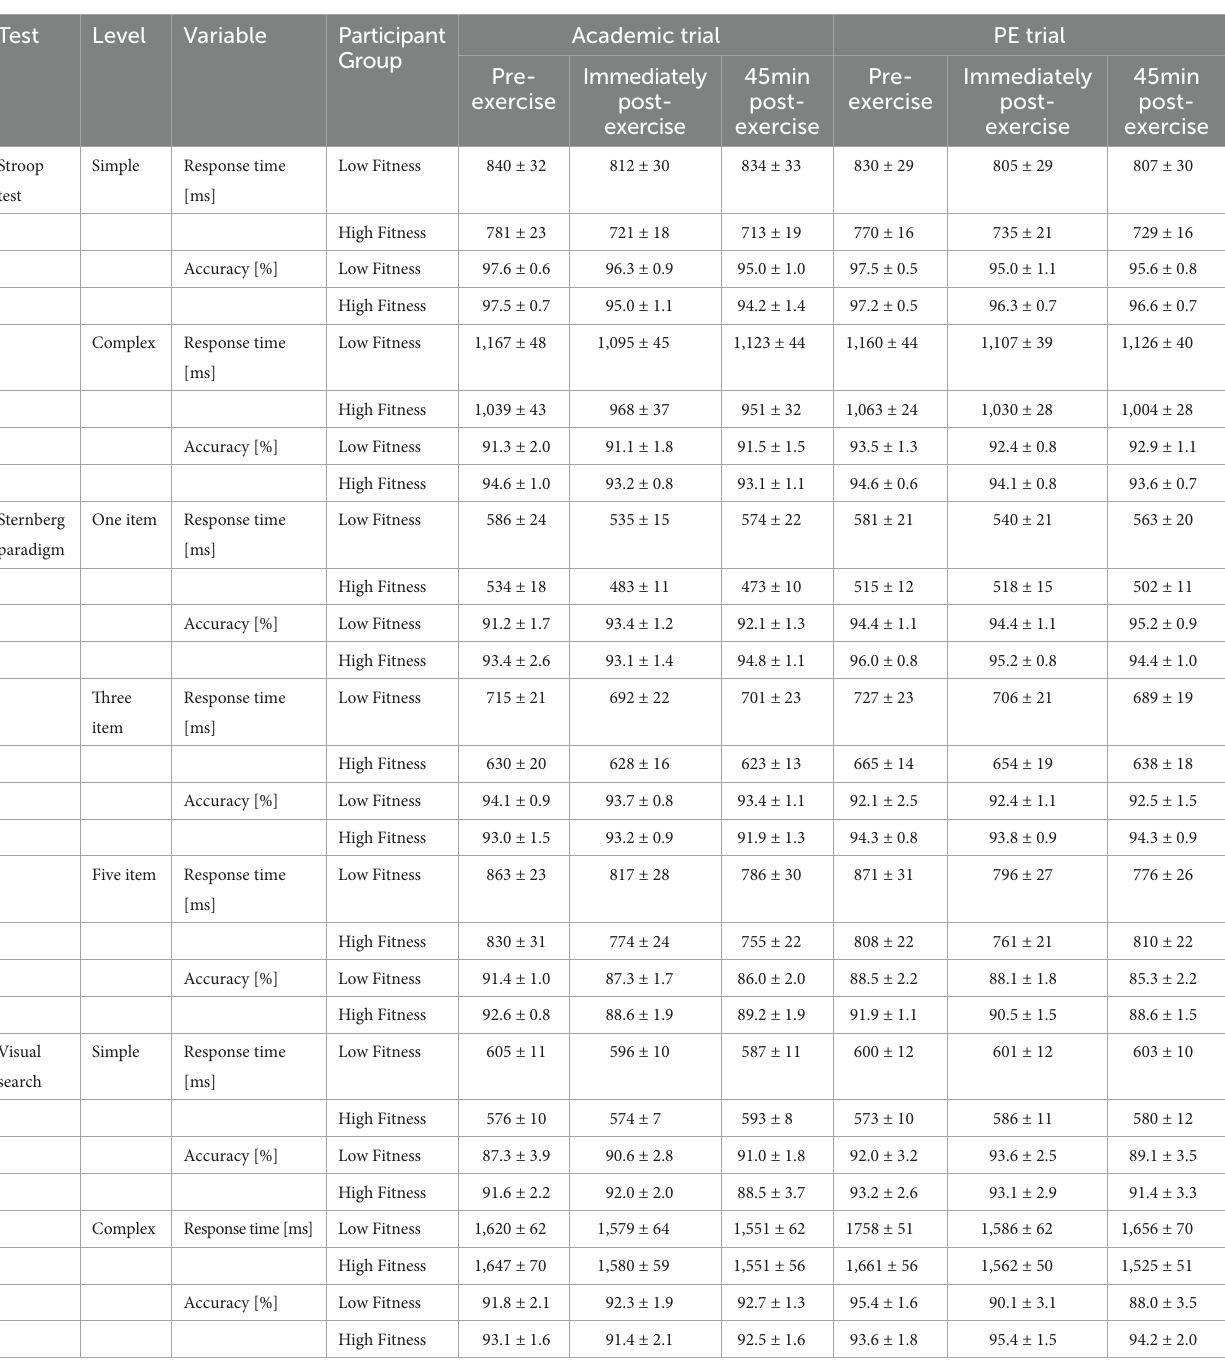
TABLE 4 Cognitive function data across the academic and PE trials for the high and low fitness